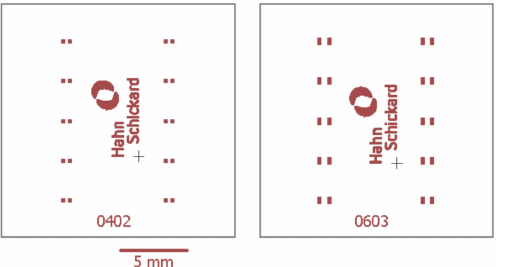
Figure 1. Circuit layout for shear tests of 0402 and 0603 SMDs (surface mounted